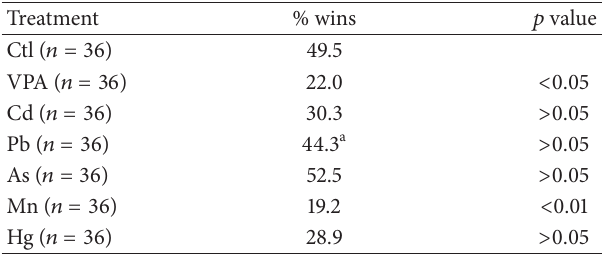
Table 1: Tube test for social